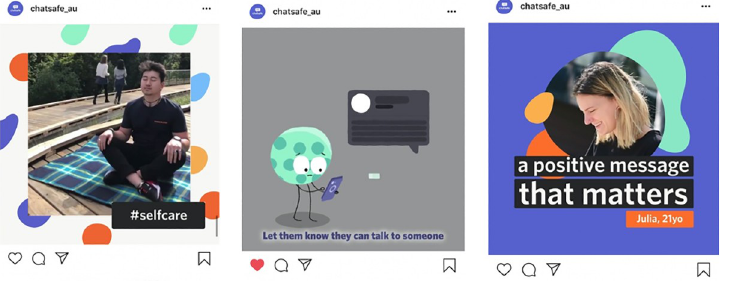
Fig 2. Examples of social media content shared during the #chatsafe campaign. Image 1: A still image of a short video (with no audio) depicting a young person “taking a break”. Image 2: A still image of an animation video